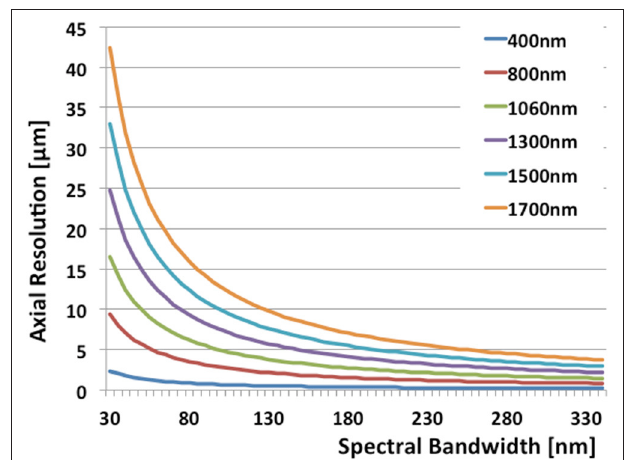
FIGURE 2 | The relation of axial resolution and spectral bandwidth in OCT according to Equation 1 for typical wavelengths.